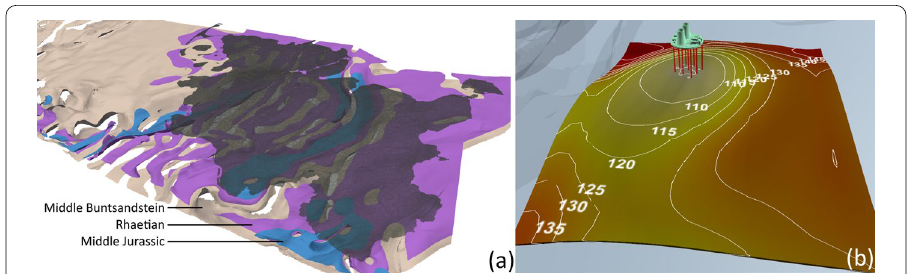
Fig. 2 a Storage formation distribution map below the region of interest. The state of Schleswig-Holstein is shown semi-transparent on top of the layers. b CAES simulation result with an adiabatic power plant and nine vertical wells are on the top of anticline structure during storage discharging (time step 2 of 13). Data in both figures have been superelevated by factor